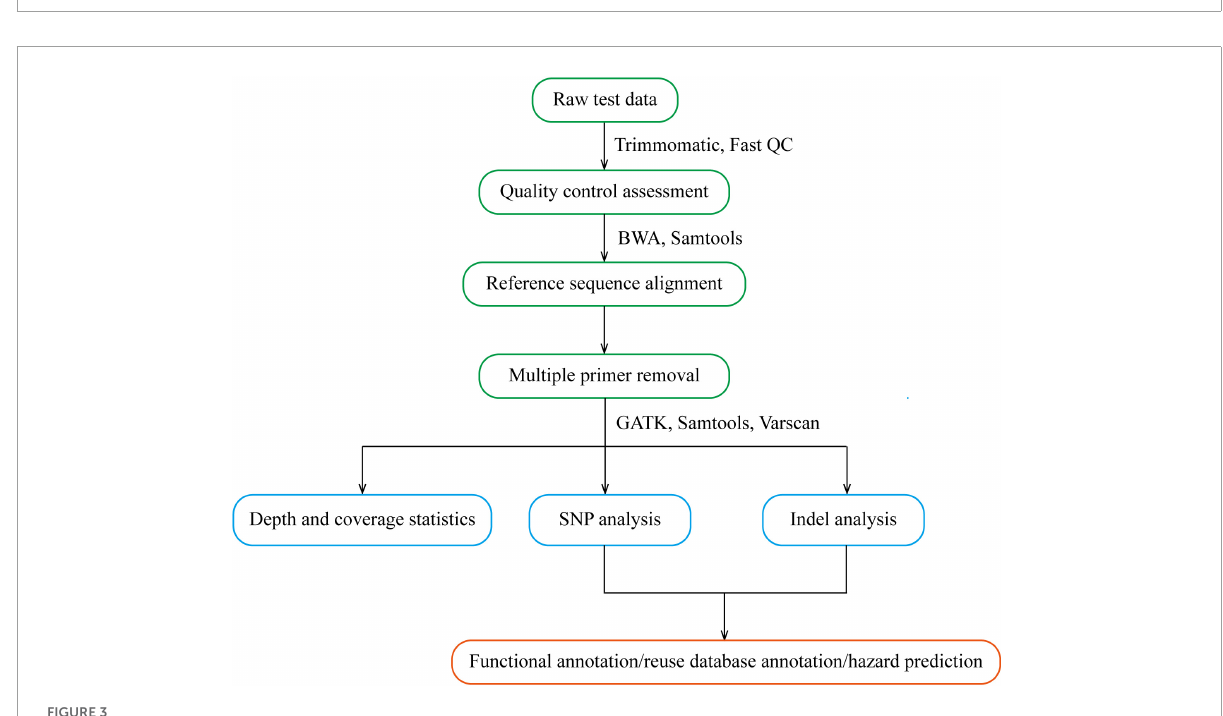
FIGURE3 Flow chart of multiple PCR bioinformatics